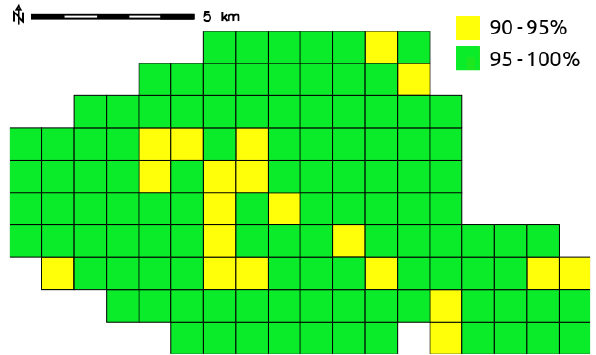
Figure 5. Percentage of OSM road length having a positional accuracy higher than or equal to 8 m for each cell